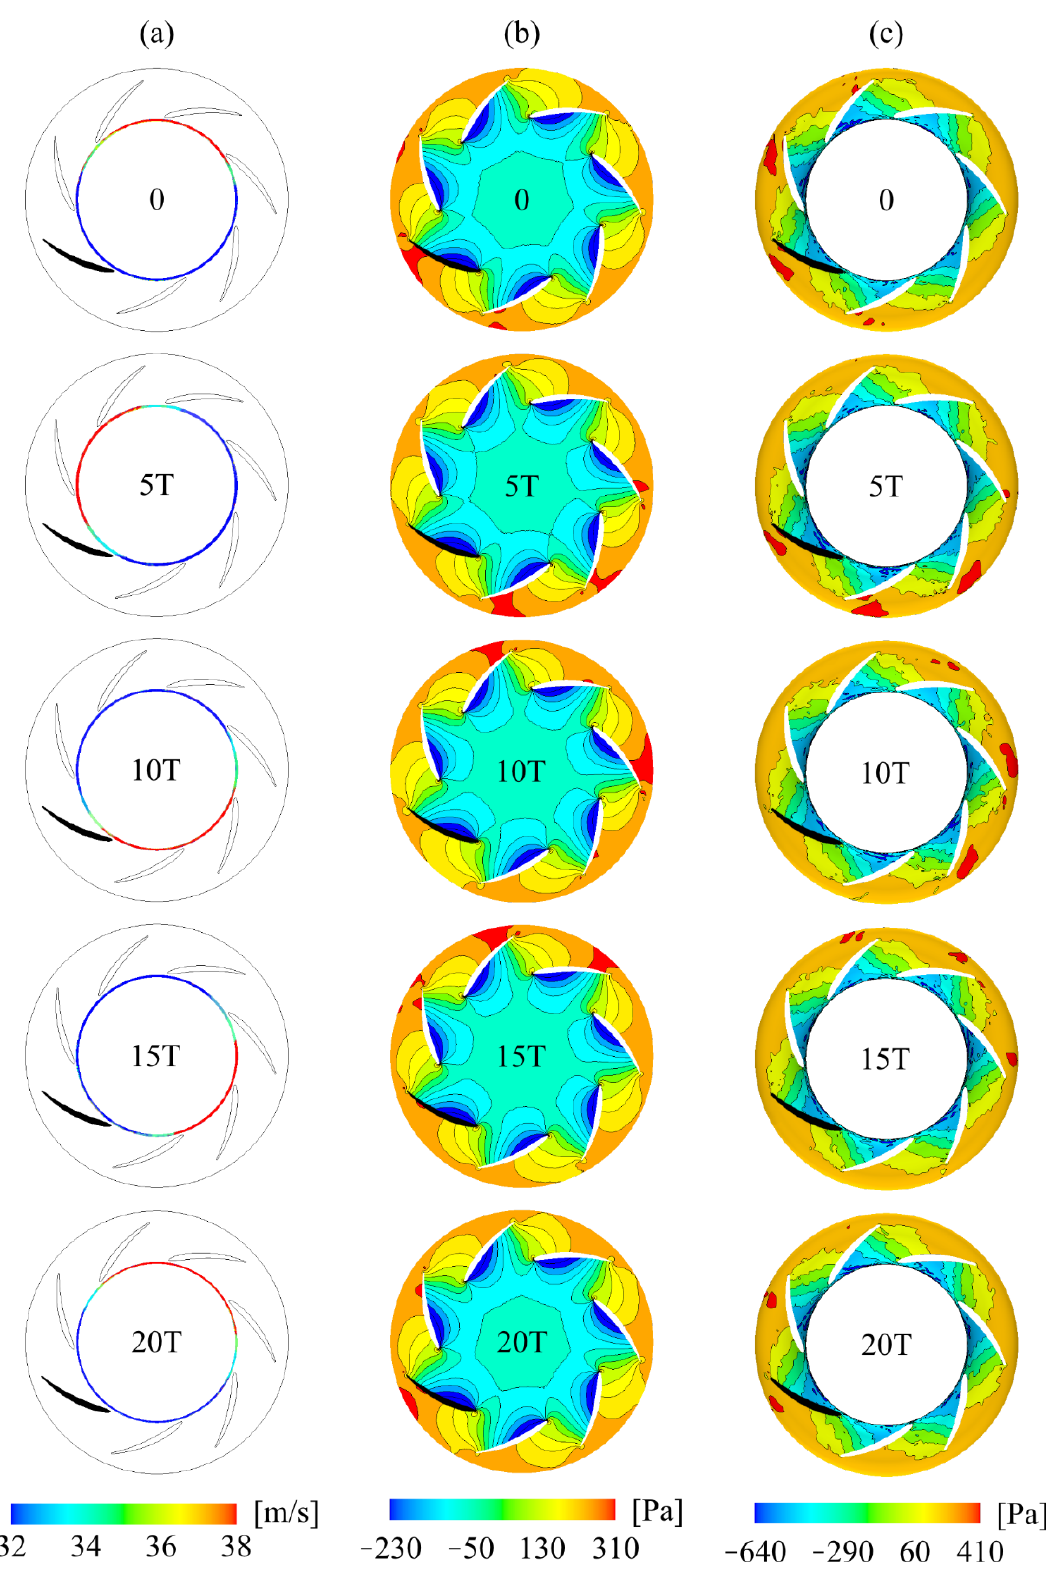
Figure 16. Snapshots of: ( a ) the velocity magnitudes within the gap, ( b ) the pressure in Plane 2, and ( c ) the pressure on the shroud surface. To indicate the fan rotation process, Blade 3 is colored black.